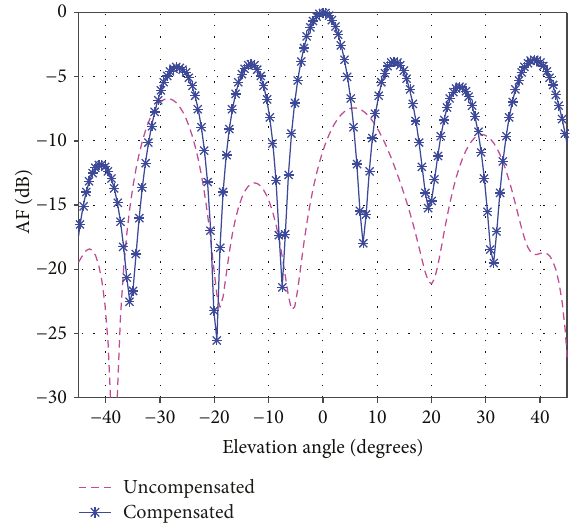
Figure 8: Array pattern of the MRA (M2) bent in the yz -plane.